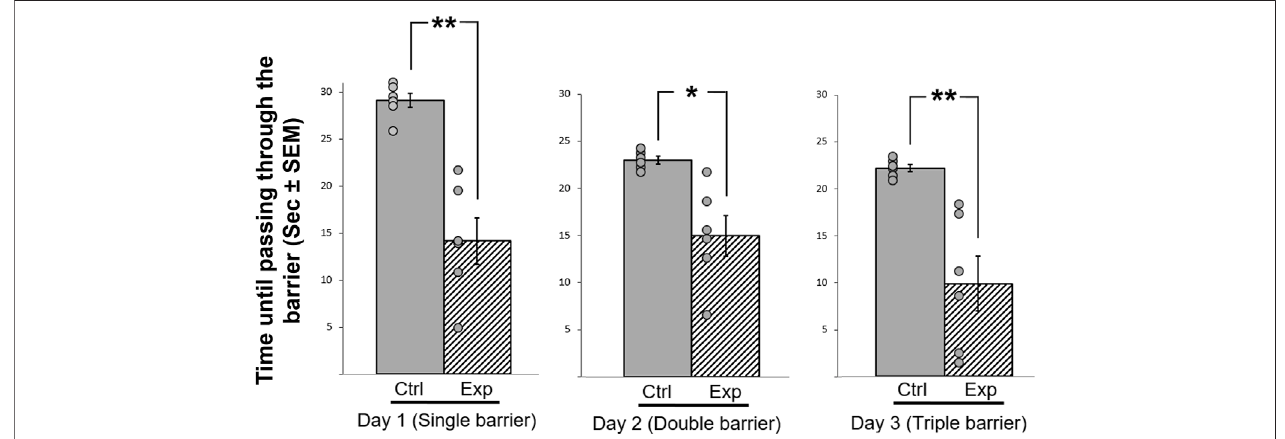
FIGURE 7 | Effect of GSK-3 β inhibition on the time (sec± SEM) taken to pass a barrier with increasing dif fi culty every day, during three consecutive days. The time taken to pass through the barrier is represented relative to the maximum of 10 min allowed, which is shown as maximum of 30 s. N = 6 birds/group; * p < 0.01; ** p < 0.001. Ctrl = control birds; Exp = GSK-3 β -inhibited birds. Dots represent individual